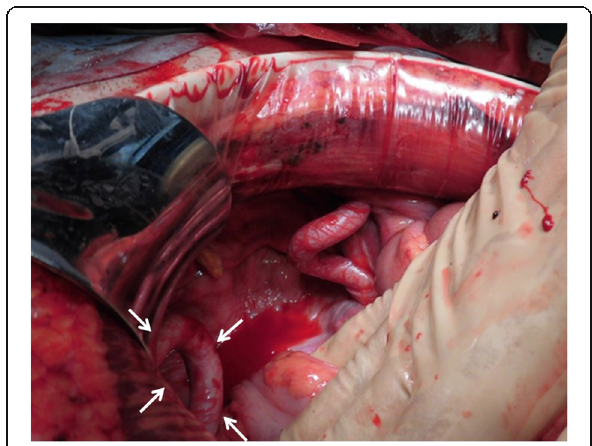
Fig. 3 Photograph after the release of the incarcerated ileum. The orifice created by the left external iliac artery (arrow) was left unrepaired